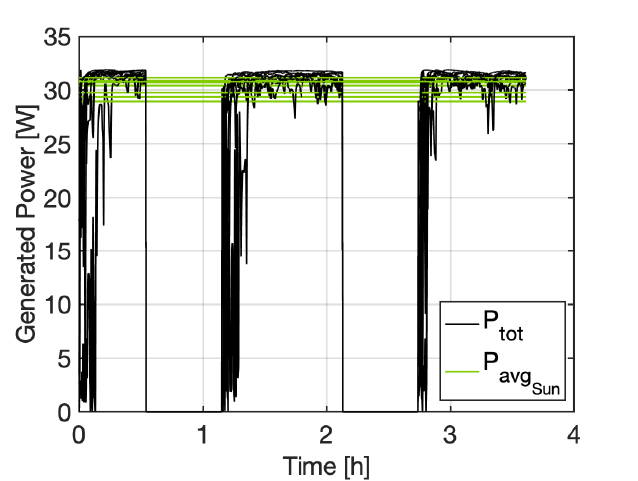
Figure 9. Solar arrays power Monte Carlo analysis, with eclipses and momentum exchange